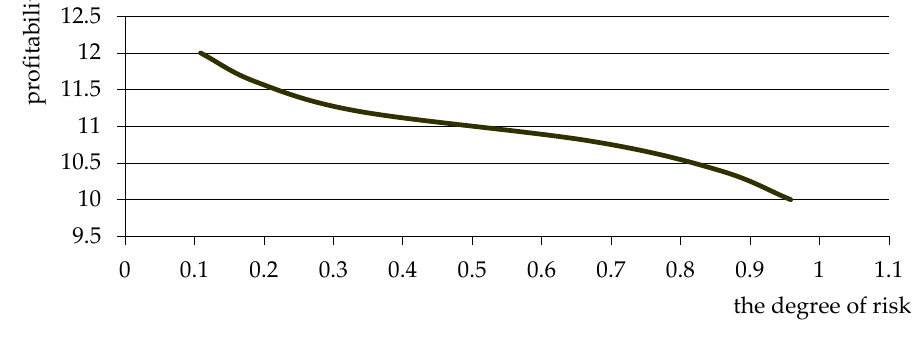
Figure 3. The dependence “risk-expected profitability”.